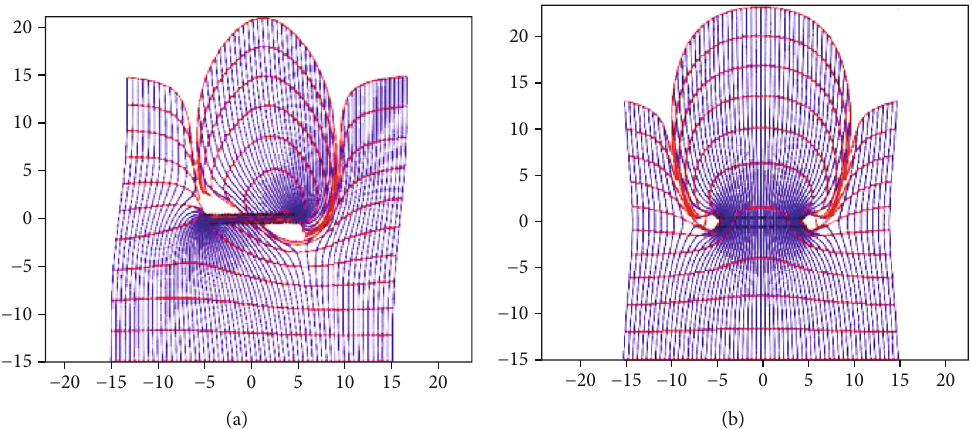
Figure 6: Particle path (blue) and TOFC (red) for (a) the original areal doublet solution [17] and (b) the augmented areal doublet solution [7]. Models in (a) and (b) both have a fracture strength of 3 : 12 × 10 − 6 m 4 /s . Despite the high incidence angle, the particle paths for the augmented solution in (b) stay mostly aligned with the far- fi eld fl ow, even inside the fracture zone (except near the fracture